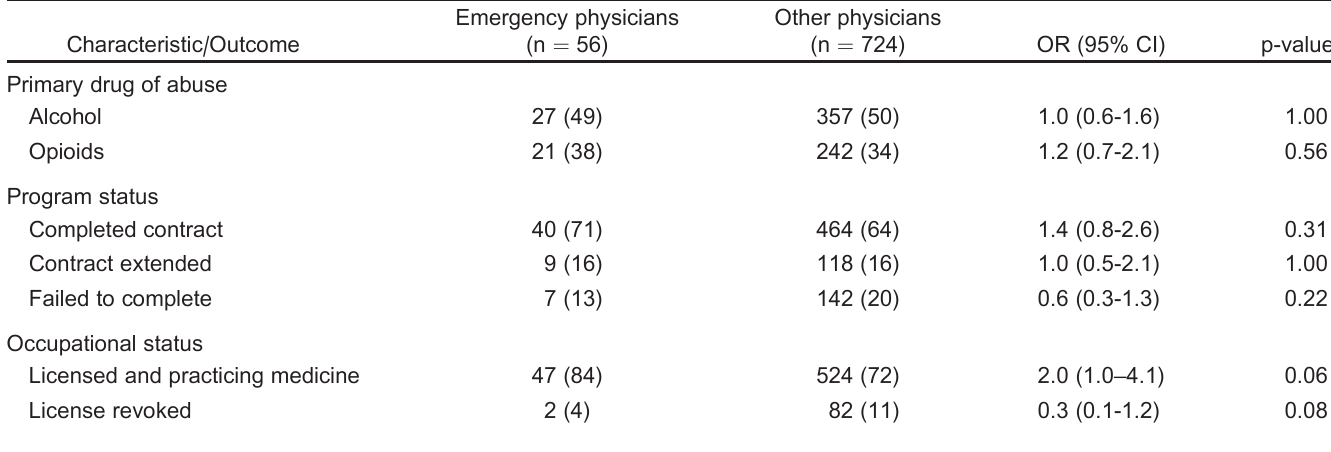
Table 3. Odds ratios (OR) for selected characteristics and outcomes of emergency physicians and other physicians in state physician health programs for substance use disorders.